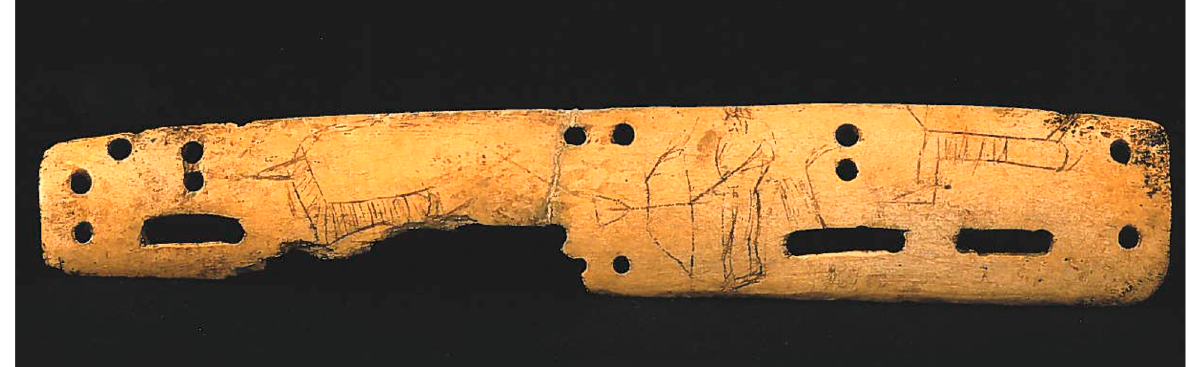
Figure 2. Bone plaque with hunting scene, 15 × 2.5 cm, excavated from Jalainur Cemetery, Inner Mongolia. From first to third century CE. After (Shanghai bowuguan 2000, p. 137).